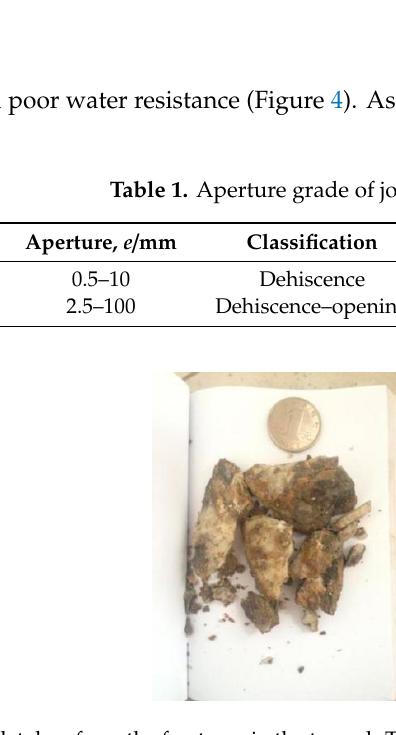
Figure 4. Sample of rock taken from the fractures in the tunnel. The soluble salt filling can be easily seen.